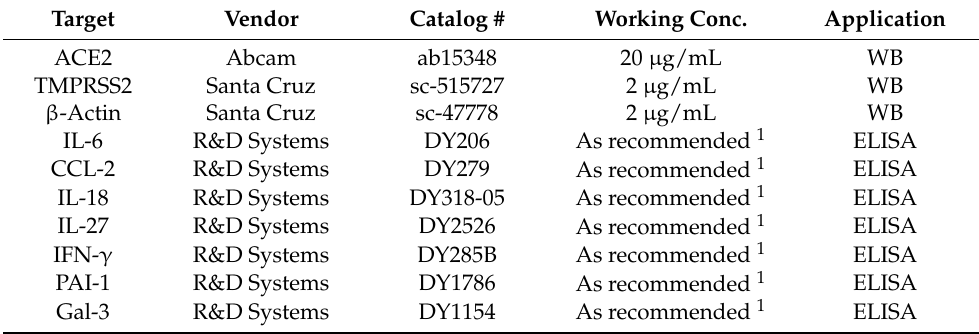
Table 1. Major resources